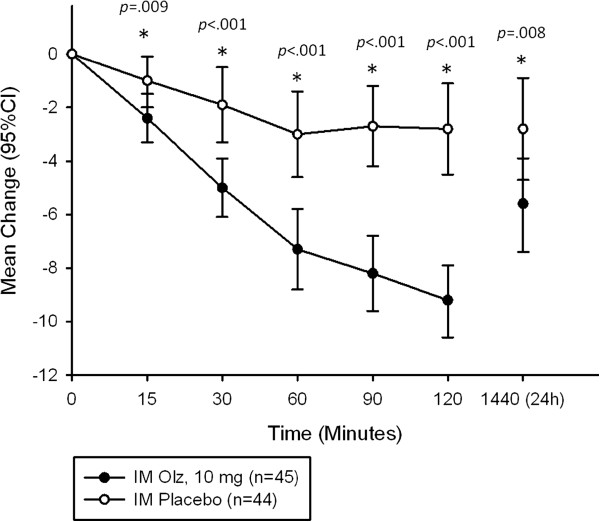
Time-course change from baseline in PANSS-EC total score up to 24 hours after administration.PANSS-EC total score for timepoint-wise change from baseline to 24 hours after the first IM injection, full analysis set, IM Olz, 10 mg (n=45), IM Placebo (n=44). Abbreviations: CI=confidence interval; IM Olz=intramuscular olanzapine *statistically significant difference between groups.